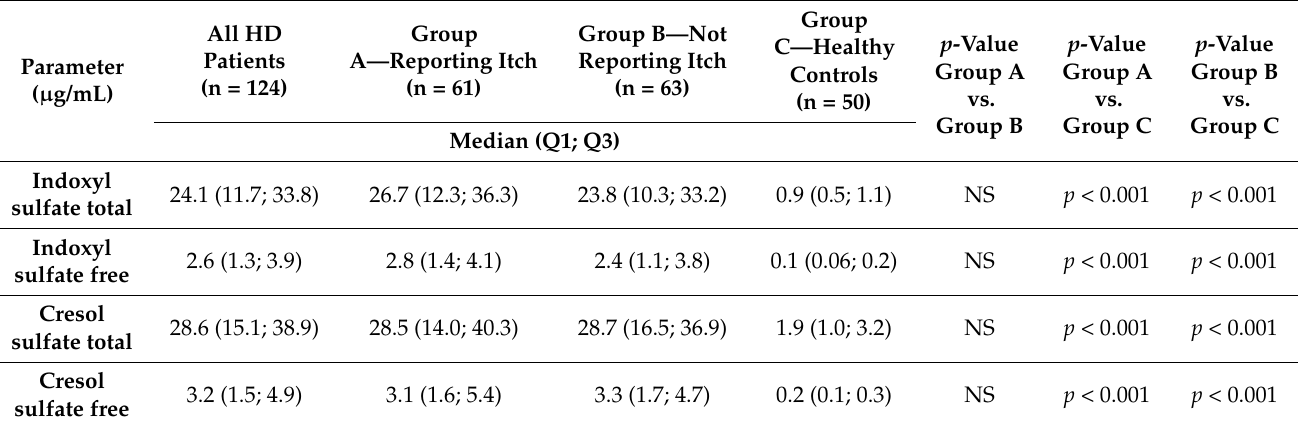
Table 1. Concentrations of free and total Indoxyl Sulfate and p-Cresol Sulfate in HD patients reporting